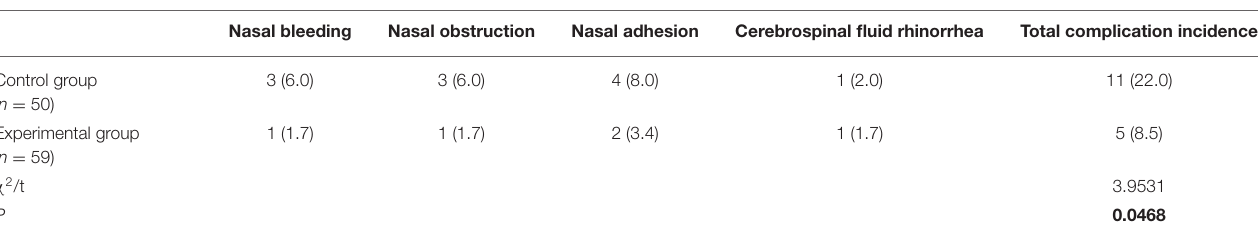
TABLE 5 | Comparison of complications of patients between the two groups. Nasal